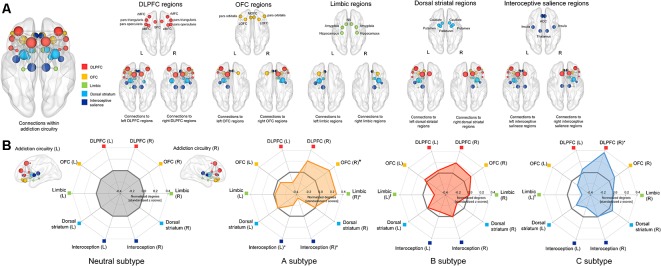
Schematic representation of the group-averaged reconstructed structural brain network among the brain regions (nodes) related to the addiction circuitry, which were then grouped into 5 ROIs including the DLPFC, OFC, limbic, dorsal striatal, and interoceptive salience processing regions (A) and radar charts for the normalized network connections (degrees) of each ROI in each subtype (B). For the purpose of presentation, the spheres are colored according to the ROIs to which they belong, and are placed in the center of each brain region (node) as according to the Desikan-Killiany atlas. The node size is proportional to the number of network connections (degree). Values of normalized degrees were transformed into standardized z scores using the means and standard deviations of those from the neutral subtype. Asterisks (*) in the radar charts indicate significant differences in normalized degrees of each subtype as compared with those in the neutral subtype at permutation-adjusted P < 0.05. For presentation purposes, a marginal statistical significance of group differences in normalized degrees at permutation-adjusted P < 0.09 was also noted using crosses (†). DLPFC, dorsolateral prefrontal cortex; rMFC, rostral medial frontal cortex; SFC, superior frontal cortex; cMFC, caudal medial frontal cortex; OFC, orbitofrontal cortex; LOFC, lateral orbitofrontal cortex; MOFC, medial orbitofrontal cortex; NA, nucleus accumbens; ACC, anterior cingulate cortex; L, left; R, right.